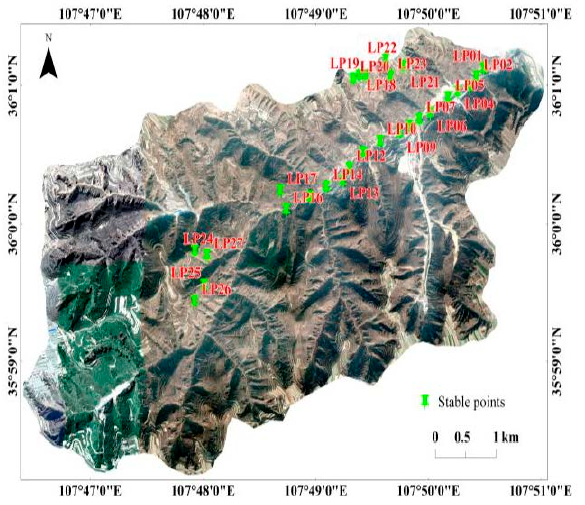
Figure 13. Distribution of stable points (landsat-7 ETM+ image obtained on 18 January 2008).